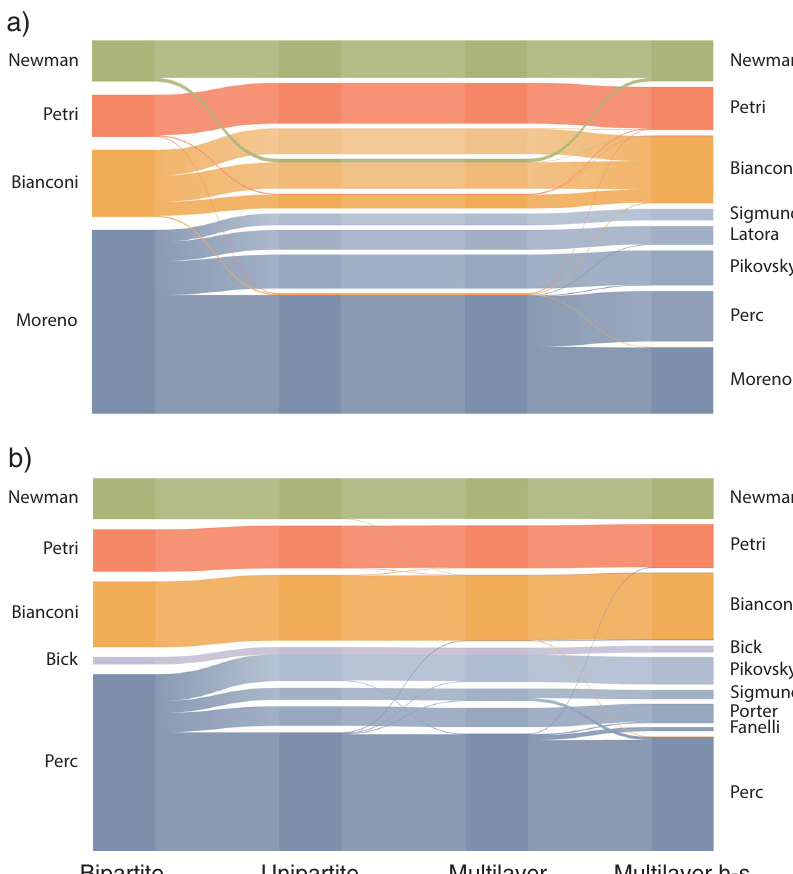
Fig. 4 Alluvial diagrams of optimised partitions for different representations of the collaboration hypergraph. Darker bars represent the modules in each partition, with height proportional to the fl ow volume of the contained nodes. Streamlines connect modules that contain the same nodes. Lazy walks in a and non-lazy walks in b . Module names from the top-ranked author within each module. Colours derive from the bipartite representations' partition and differentiate author-groups that collaborate more within the group than with authors in other groups. h-s